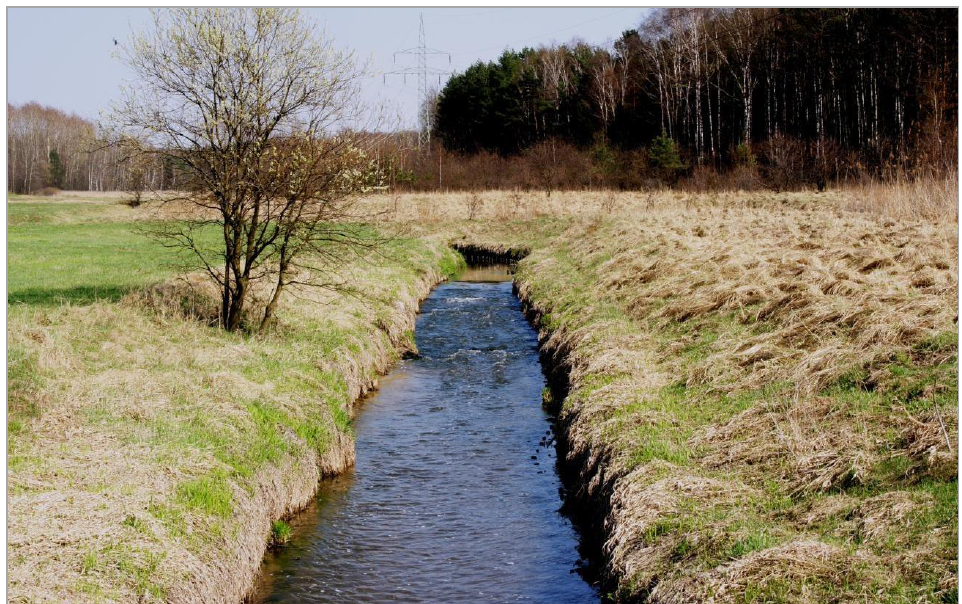
Fig. 2. Kłodnica's riverbed in the city of Ruda Śląska ( K. Mazurek